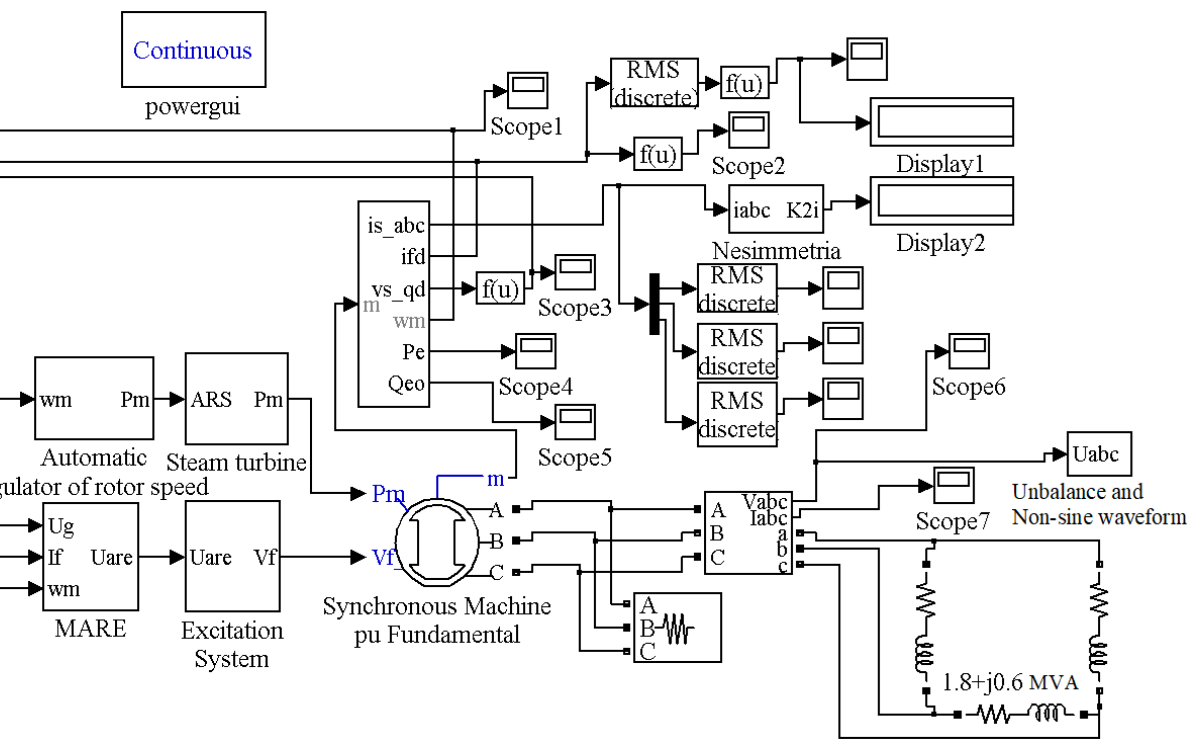
Figure 1) additionally takes into account the amplifier and the limiting block. The block diagram of the excitation system model is shown in Figure